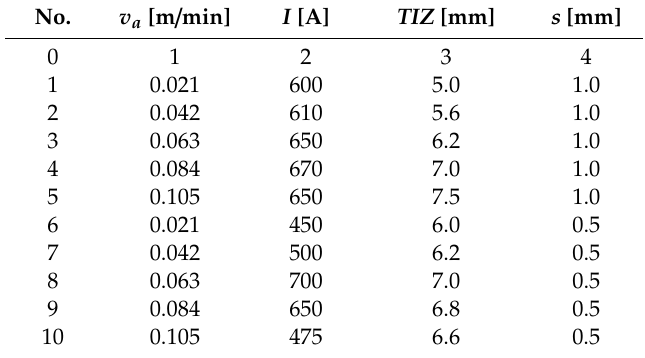
Table 10. The dependence of the thermal influenced zone, on the feed rate of PO and on the thickness of the metal